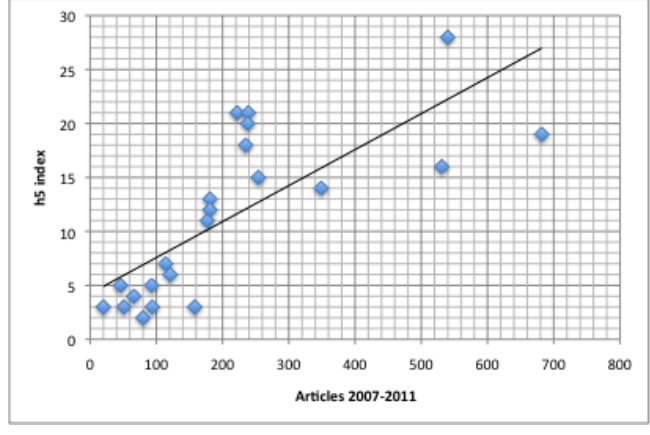
Figure 2 H5 index for citations in Google Scholar. The journals can be identified by comparing the x- and y-values with table 4. Journals above the line perform above